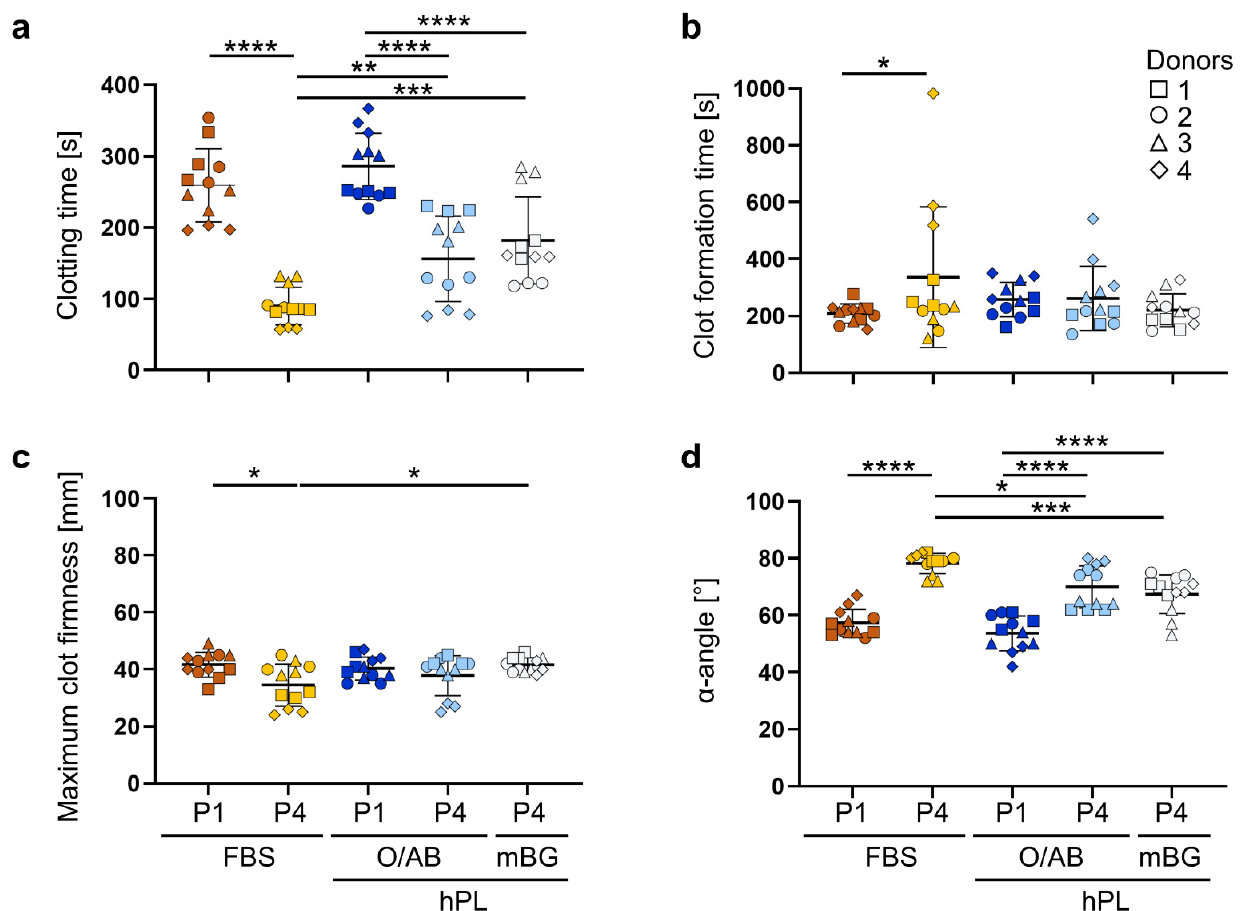
Figure 6. Coagulation activity of early (P1) and late passage (P4) BMSCs. ( a ) Significantly shortened clotting time values after 4 passages in FBS, more than hPL O/AB and hPL mBG, compared to passage 1, respectively. Repeated measures, one-way ANOVA with multiple comparisons (Tukey). ( b ) The clot formation time and ( c ) maximum clot firmness showing limited donor dependent differences. Clot formation time: Friedman test with multiple comparisons (Dunn); maximum clot firmness ANOVA as in ( a ). ( d ) Significantly increased α -angles resulting from higher procoagulant activity of all late (P4) BMSCs, compared to early (P1) BMSCs; statistics as in ( b ). Results of 4 donors analyzed in triplicate, symbols as indicated; p-values of multiple comparisons as depicted—* p < 0.5, ** p < 0.01, *** p < 0.001, **** p < 0.0001, ns, not significant.